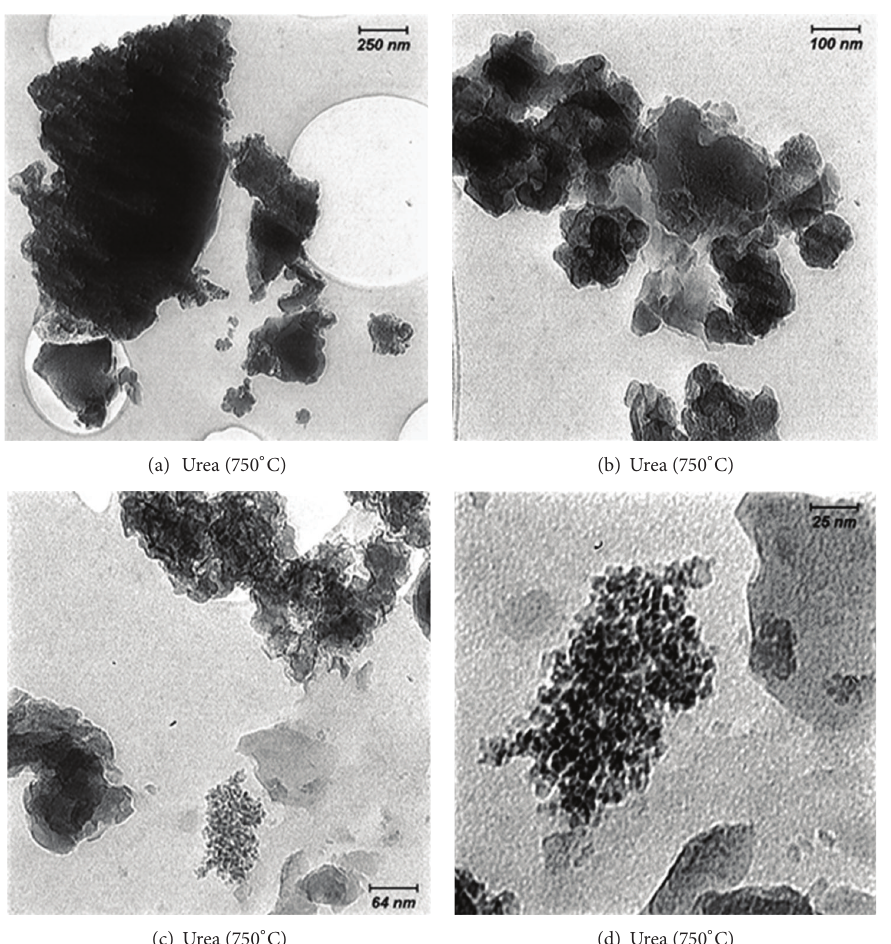
Figure 6: TEM images of Al 2 O 3 nanoparticles prepared with urea at 750 ∘ C at different scales of the microscope